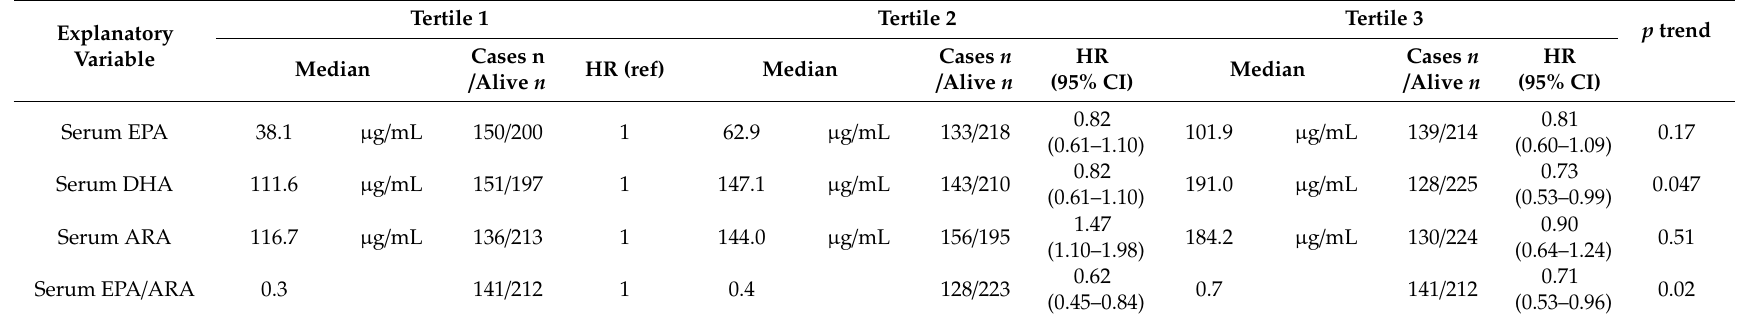
Table 3. Multivariate-adjusted hazard ratios 1 for all-cause mortality of serum EPA, DHA, and ARA ( n =